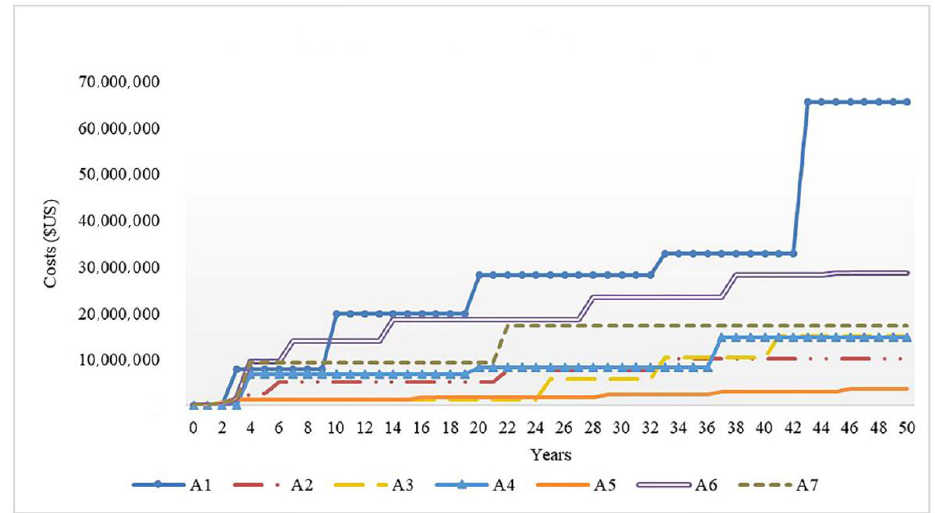
Figure 6. Estimated annual pumping costs by alternative.